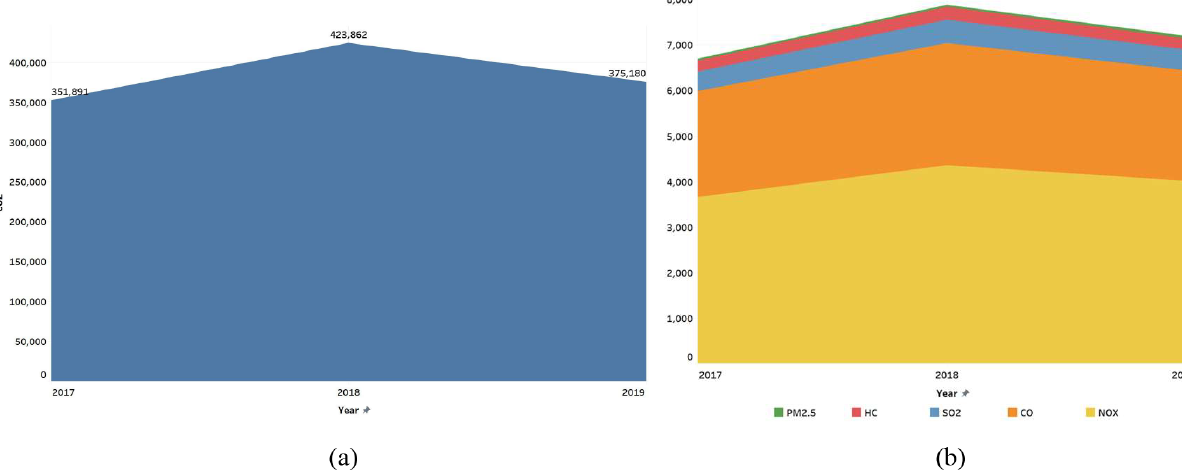
Figure 12. Changes in average emissions of six pollutant airlines after the CNG2020 strategy was proposed (tonnes). (a) Average overall airline emissions of CO 2 from 2017 to 2019. (b) Average overall airline emissions of the other five pollutants from 2017 to